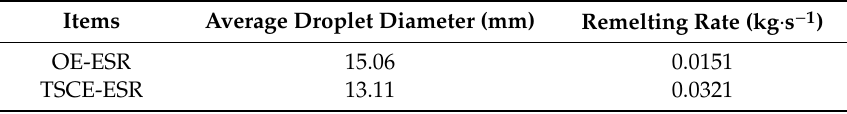
Table 5. Droplet average diameter and remelting